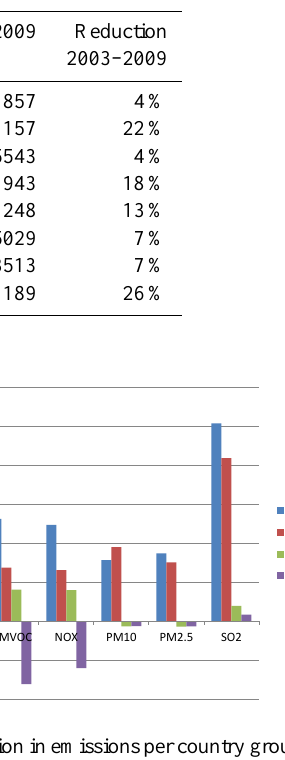
Table 3. Overview of total emissions (kilotonne) per pollutant and year for UNECE-Europe (including international shipping), and the overall reduction in the time period 2009–2003.